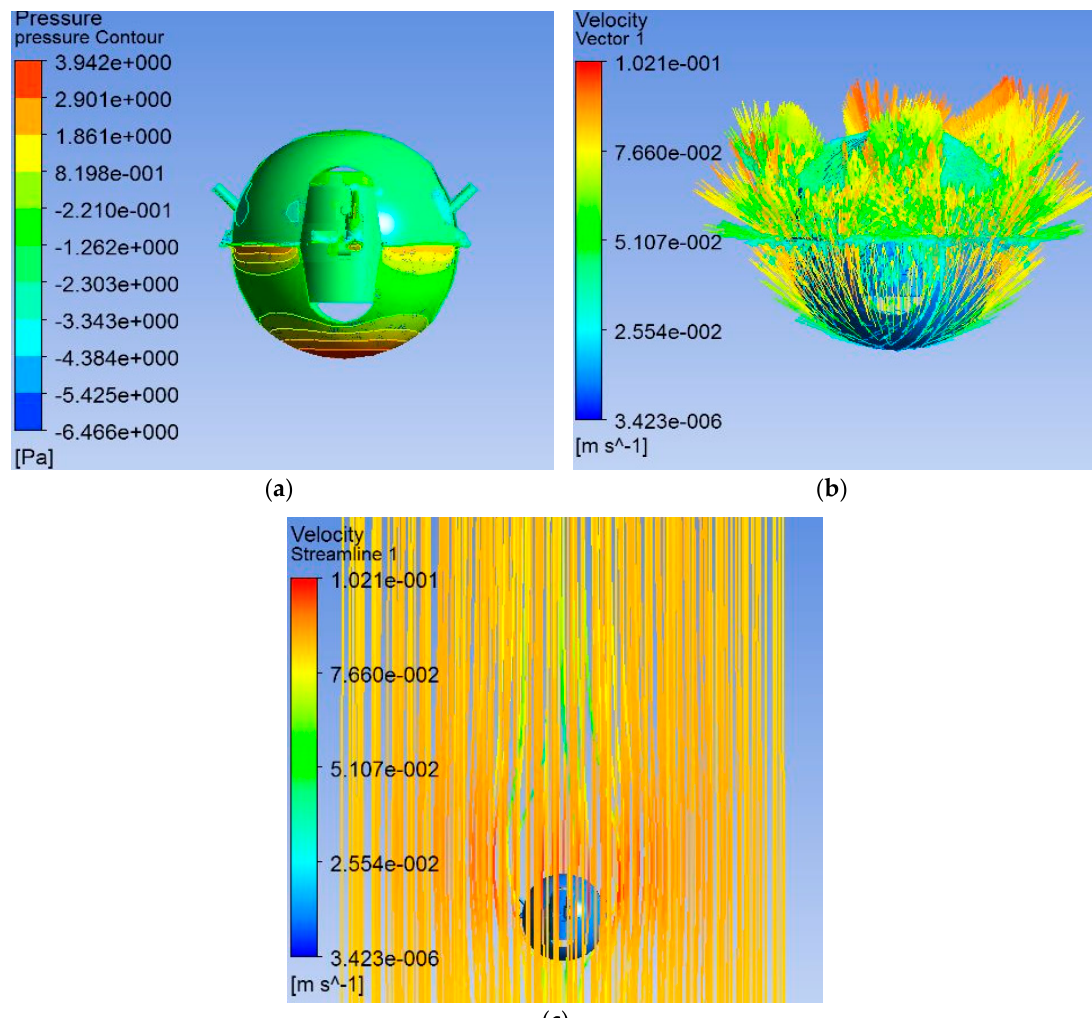
Figure 15. Down motion in heave. ( a ) Pressure contour; ( b ) Velocity vector; ( c ) Velocity streamline.